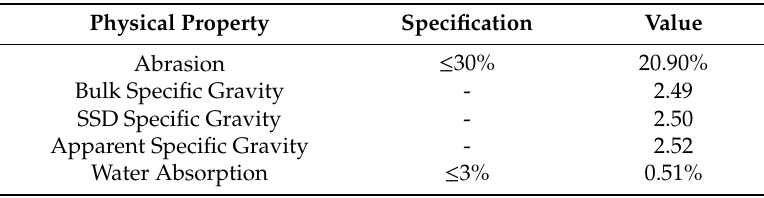
Table 3. Physical properties of coarse